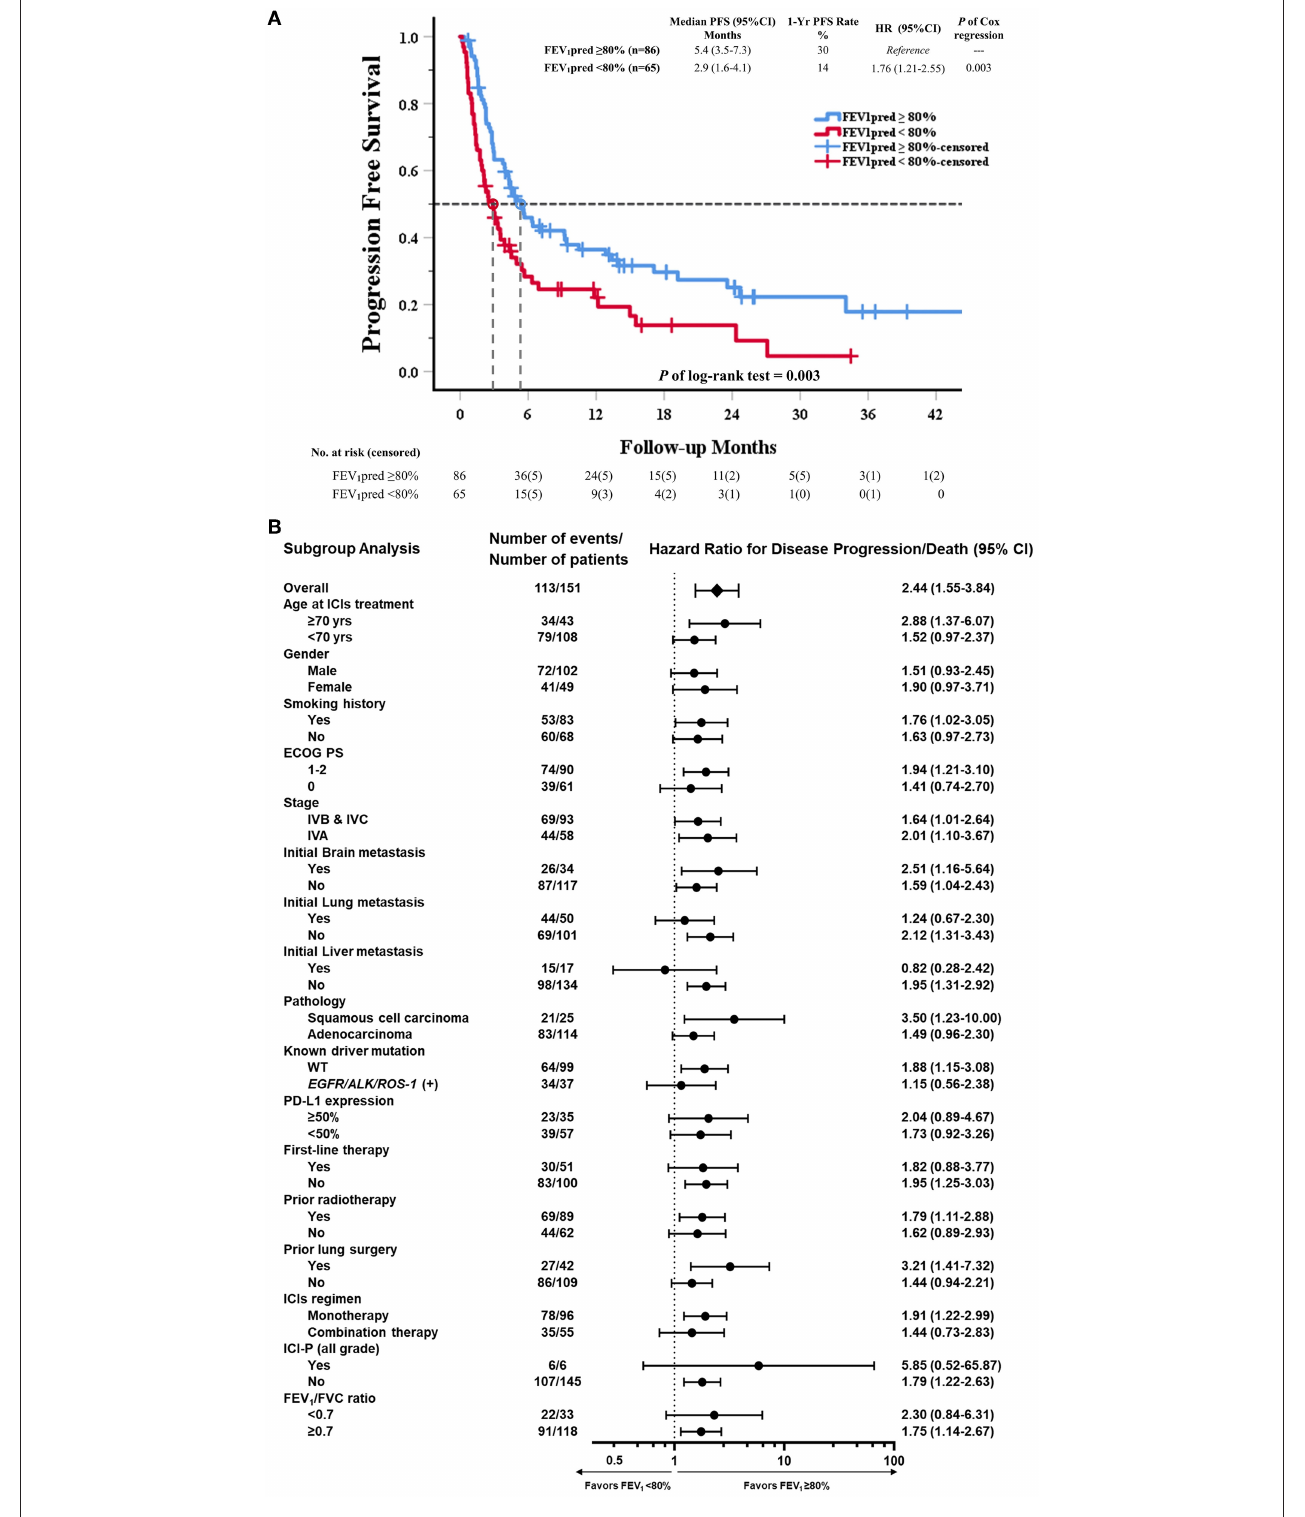
FIGURE 2 | Kaplan–Meier curve of PFS and subgroup analysis of PFS in all patients received ICI (80% of predicted FEV 1 as a cut-off value of FEV 1 ). (A) The Kaplan–Meier curve estimates of PFS, according to using 80% of predicted FEV 1 as a cut-off value. Tick marks represent data censored at the last time the patient was known to be alive and without disease progression. Progression free survival was assessed according to Response Evaluation Criteria in Solid Tumors (RECIST), version 1.1, and the data reviewed by authors group. (B) The data sheet and Forest plot shows the analysis of PFS in all subgroups. Vertical dotted line in subgroup analysis represents HR, showing PFS benefit for FEV 1 pred ≥ 80% compared with FEV 1 pred < 80% in all subgroups evaluated.